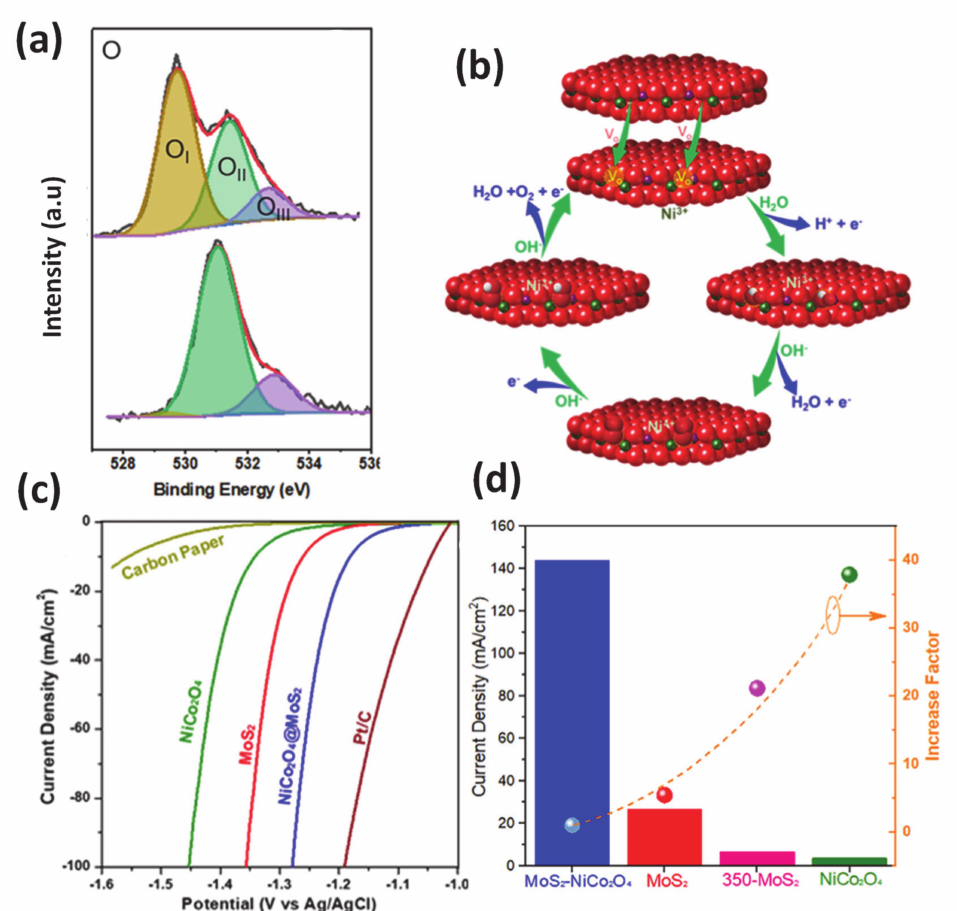
Figure 8. ( a ) XPS spectra of O 2s ( b ) The proposed OER cycles over the NiCo 2 O 4 @MoS 2 , where the formation of OH − , O 2 − , and OOH − intermediates are reconciled with oxygen vacancy-mediated Ni 3 + center; the spinel structure with metal ions between interstices of two oxygen layers is used in this cartoon. HER performances of MoS 2 , NiCo 2 O 4 , and NiCo 2 O 4 @MoS 2 samples: ( c ) Polarization curves in 1M NaOH at room temperature referred to Pt / C and carbon paper and ( d ) current density with an overpotential n = 0.3 V vs. RHE (column bars), and the current density increase factor calculated by comparing j NiCo2O4@MoS2 / J sample . Produced with permission [125]. Copyright 2019, American Chemical